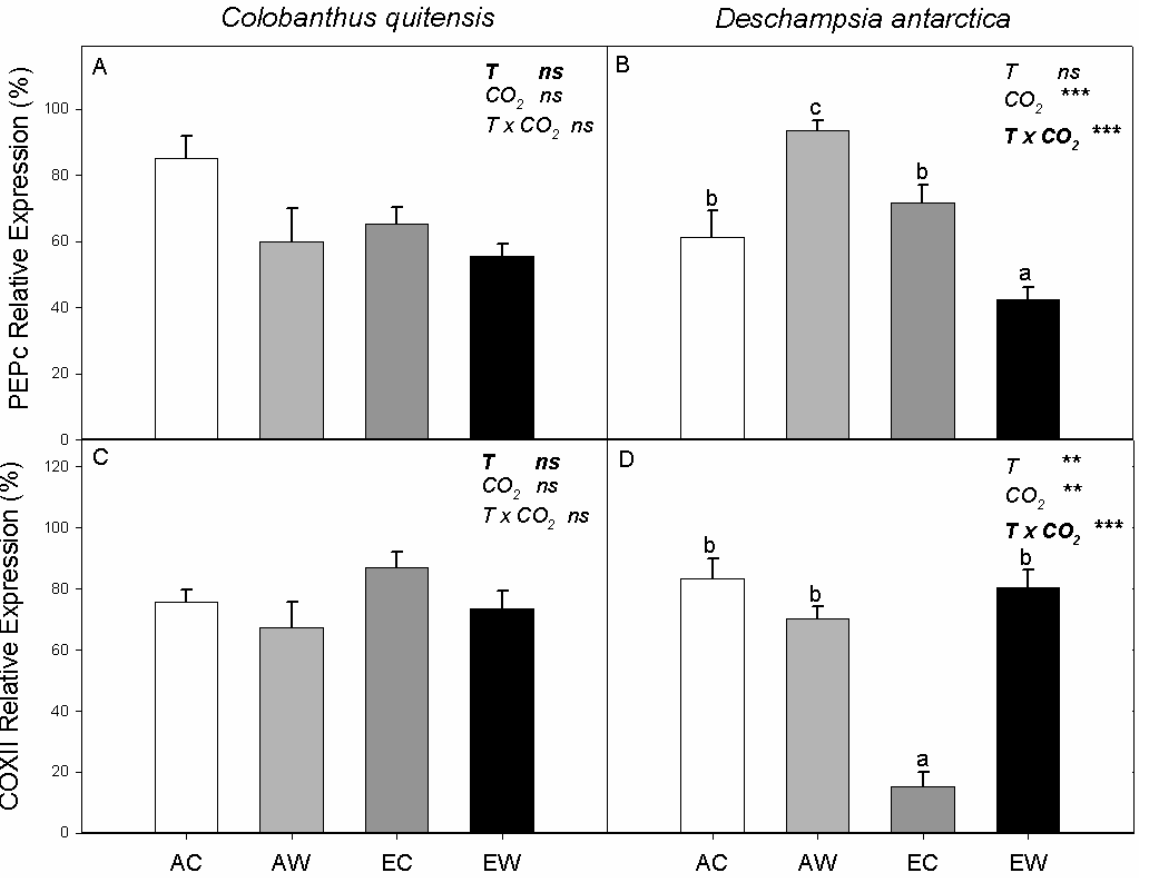
Figure 4. Relative abundance of phosphoenol pyruvate carboxylase (PEPc) and cytochrome oxidase (COX-II) proteins for C. quitensis ( A , C ) and D. antarctica ( B , D ). Treatments correspond to AC (ambient CO 2 , control thermoperiod; white bar empty), AW (ambient CO 2 , warming thermoperiod; white bar hashed), EC (elevated CO 2 , control thermoperiod; grey bar), and EW (elevated CO 2 , warming thermoperiod; grey bar hashed). Values are means ± SEM ( n = 5). For each graph, the effect of thermoperiod (T), CO 2 environment (CO 2 ), and the interaction of thermoperiod and CO 2 (T x CO 2 ), with ns indicates no significance difference, * indicates p ≤ 0.05, ** indicates p ≤ 0.01, and *** indicates p ≤ 0.001. The factor with the largest effect size is indicated in bold.